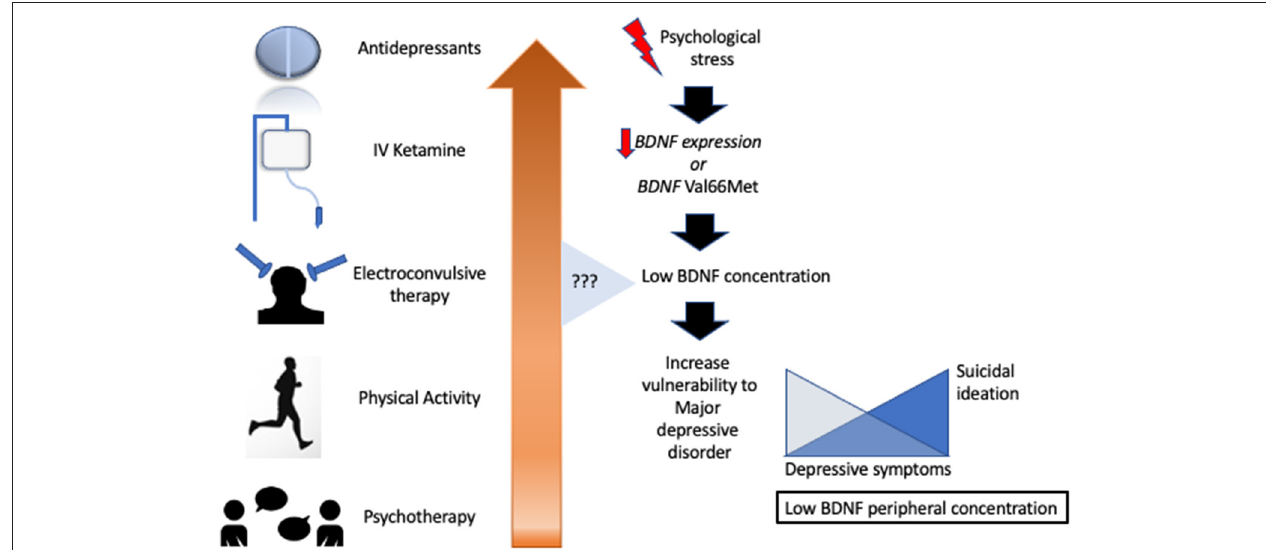
FIGURE 2 | Several antidepressant treatments aimed to increase brain-derived neurotrophic factor with heterogeneous results.